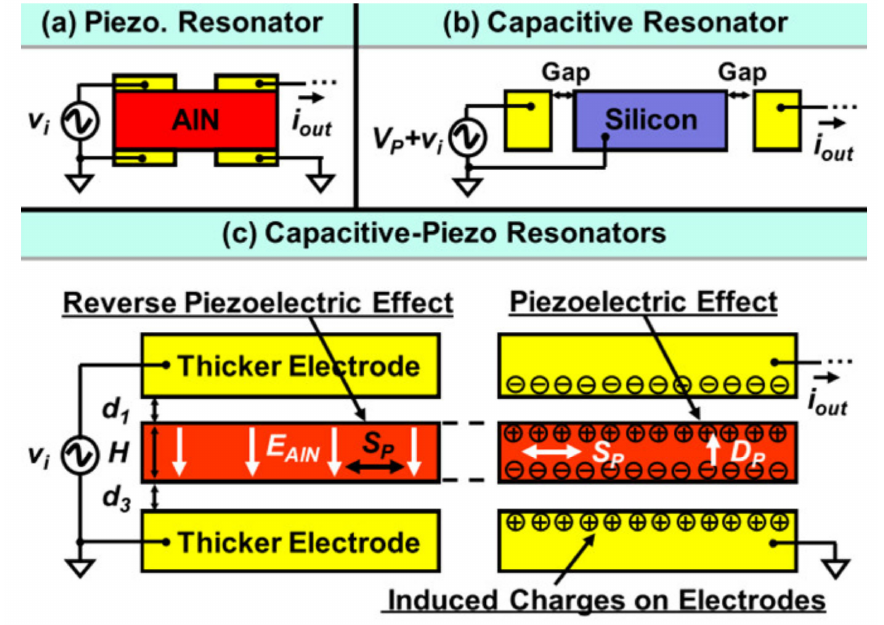
Figure 23. Working principle of a conventional piezoelectric resonator, capacitive resonator and novel capacitive-piezo resonator (Reprinted with permission from Ref.